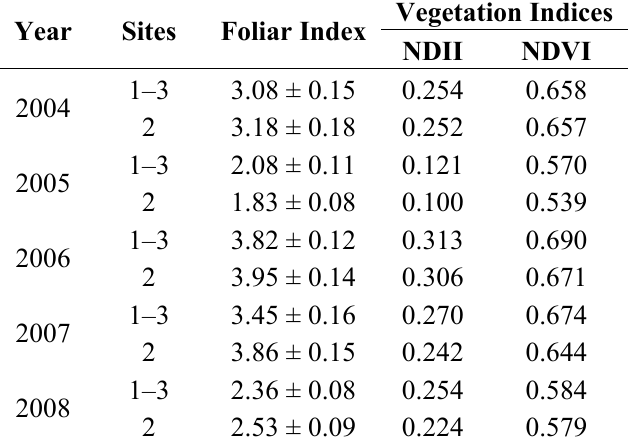
Figure 5. Associations observed between the foliar index (ratio between the dry mass of all leaves and the mass of all shoots), the Normalized Difference Vegetation Index (NDVI) and tree-ring width. Data are means ± SE. Table 1. Values of the foliar index (means ± SE) are compared with the vegetation indices for sites 1–3 and 2. All remote sensing data refer to October when primary growth was finished, excepting the 2004 images, which were taken in June. Note that the foliar index was quantified based on biomass data from branches sampled in October. Indices abbreviations are: NDII, Normalized Difference Infrared Index; NDVI, Normalized Difference Vegetation